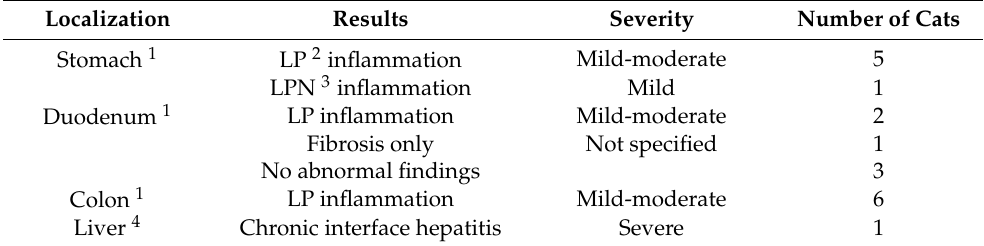
Table 2. Histopathology reports of gastrointestinal biopsies (n = 6) and liver biopsies (n = 1) from cats with presumed chronic pancreatitis treated with cyclosporine. Biopsies were collected before study inclusion.